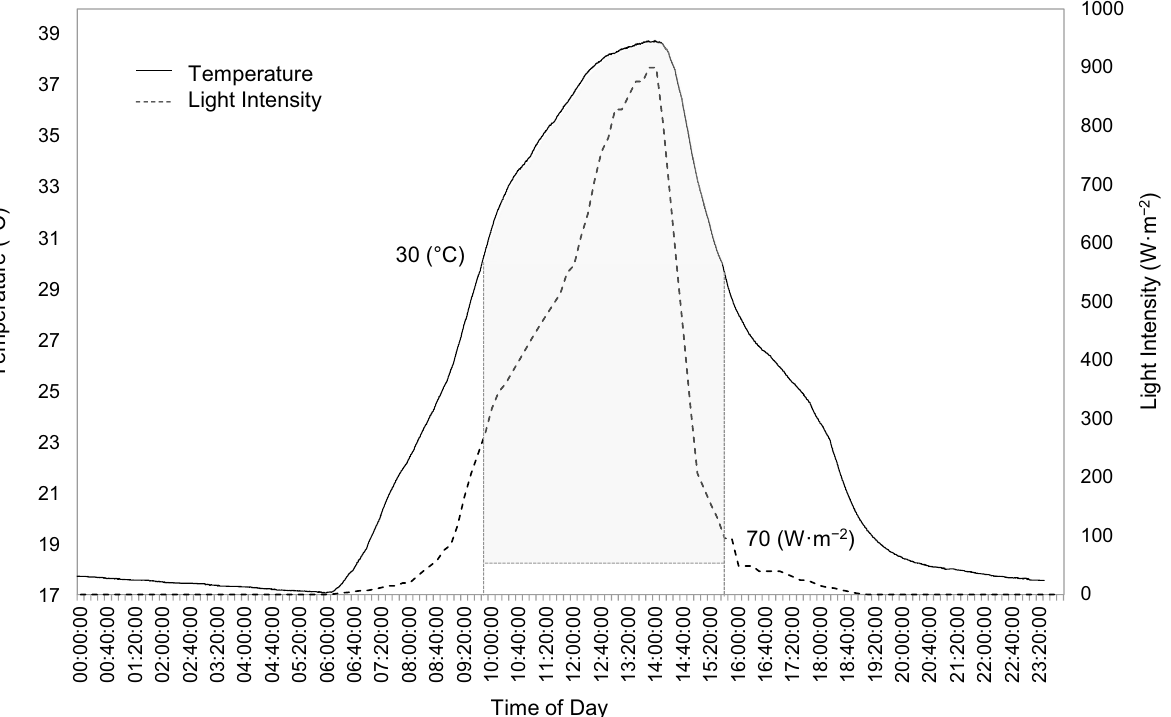
Fig. 6 Operating temperature in the TPBR under indicated diurnal light cycles (hydrogen production range indicated by shaded